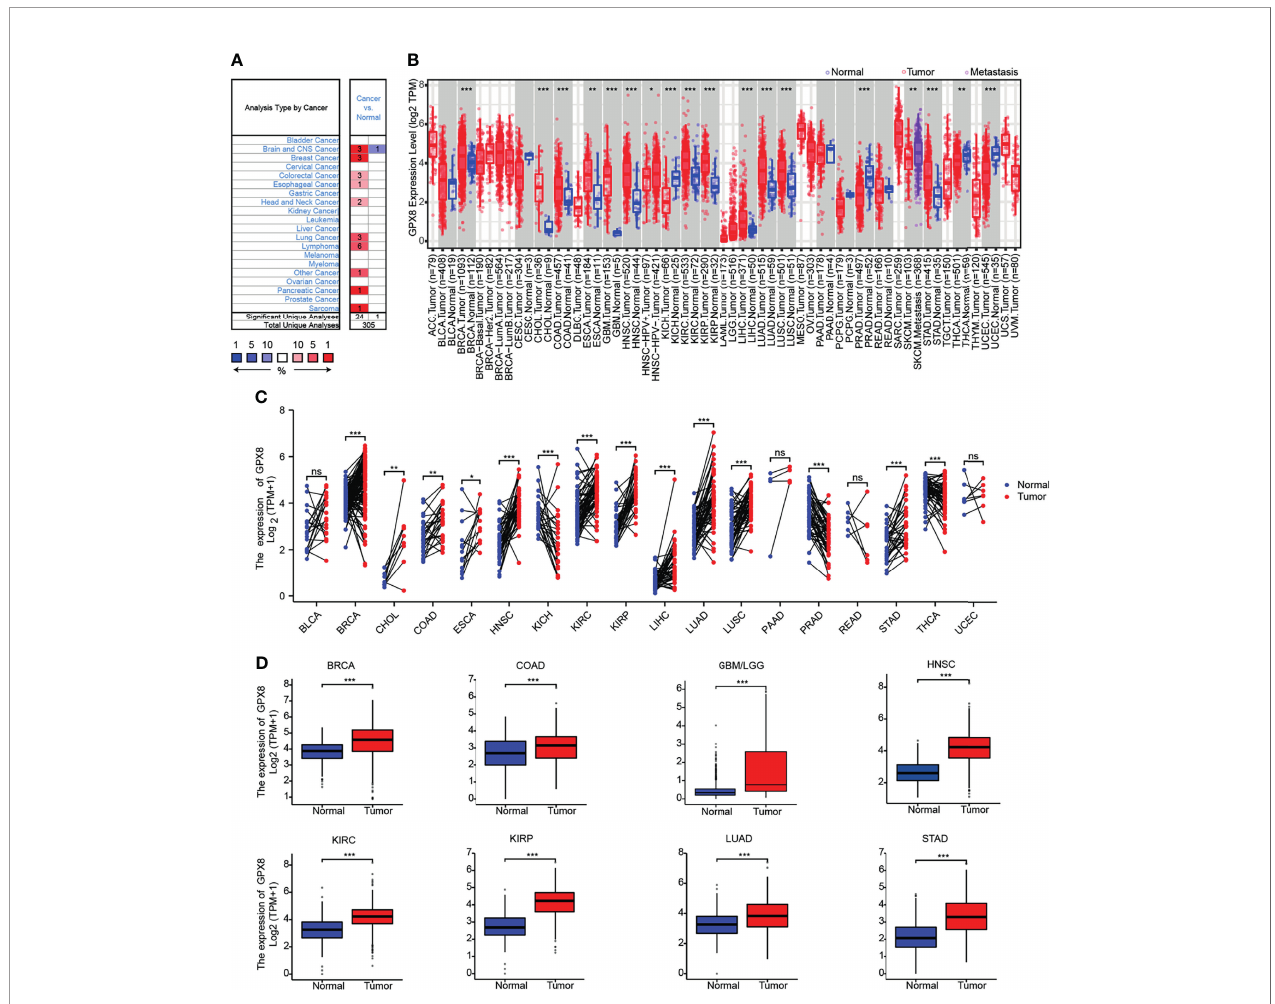
FIGURE 1 | The expression of GPX8 gene in different cancers. (A) The expression of GPX8 in pan-cancer was explored in the Oncomine database. (www. oncomine.org). (B) The expression of GPX8 in pan-cancer was explored in TCGA through TIMER. (http://timer.cistrome.org/). (C) The expression of GPX8 in pan- cancer was analyzed using paired tumor/normal samples from TCGA and GTEx databases. (D) The expression of the GPX8 was analyzed in BRCA, COAD, GBM/LGG, HNSC, KIRC, KIRP, LUAD and STAD. *P < 0.05, **P < 0.005, ***P < 0.001. “ ns ” was regarded as no statistically signi fi